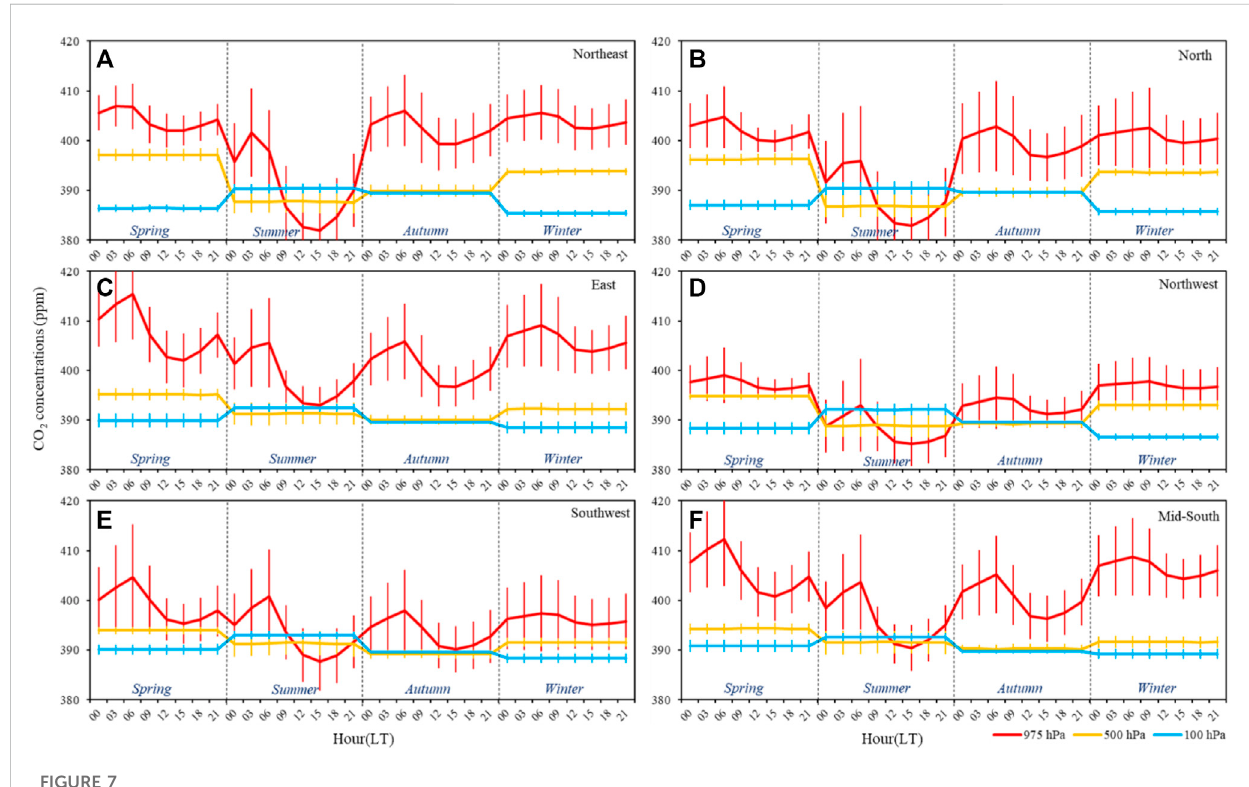
FIGURE 7 Diurnal cycles of CO 2 for the six sub-regions across